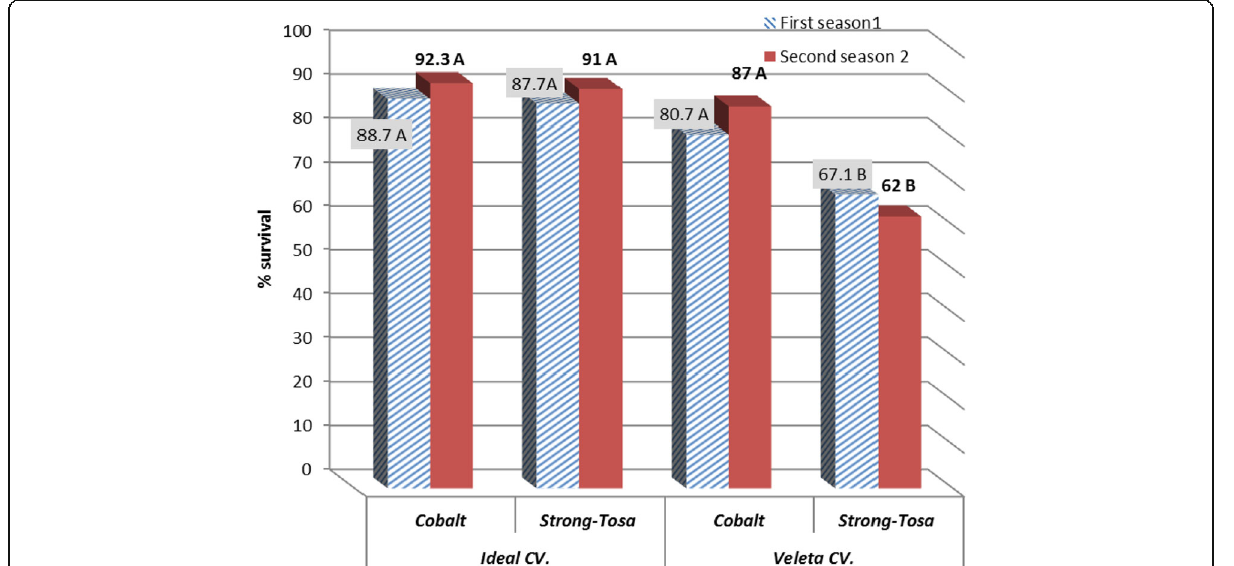
Fig. 1 % survival of cantaloupe seedling during 2015 and 2016